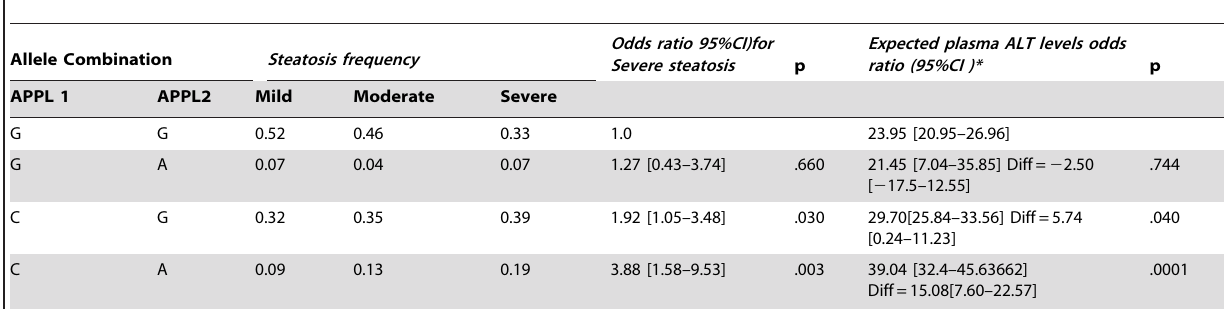
Table 5. Allele combination effect on plasma ALT levels and hepatic steatosis severity.